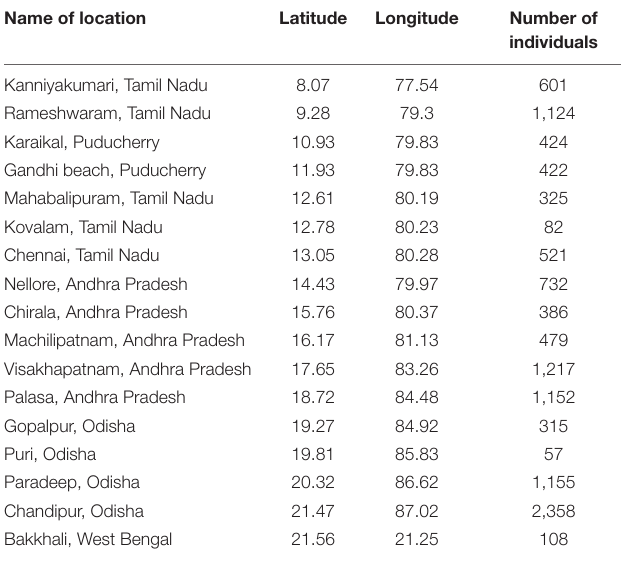
TABLE 1 | Details of the sampling locations used for the present